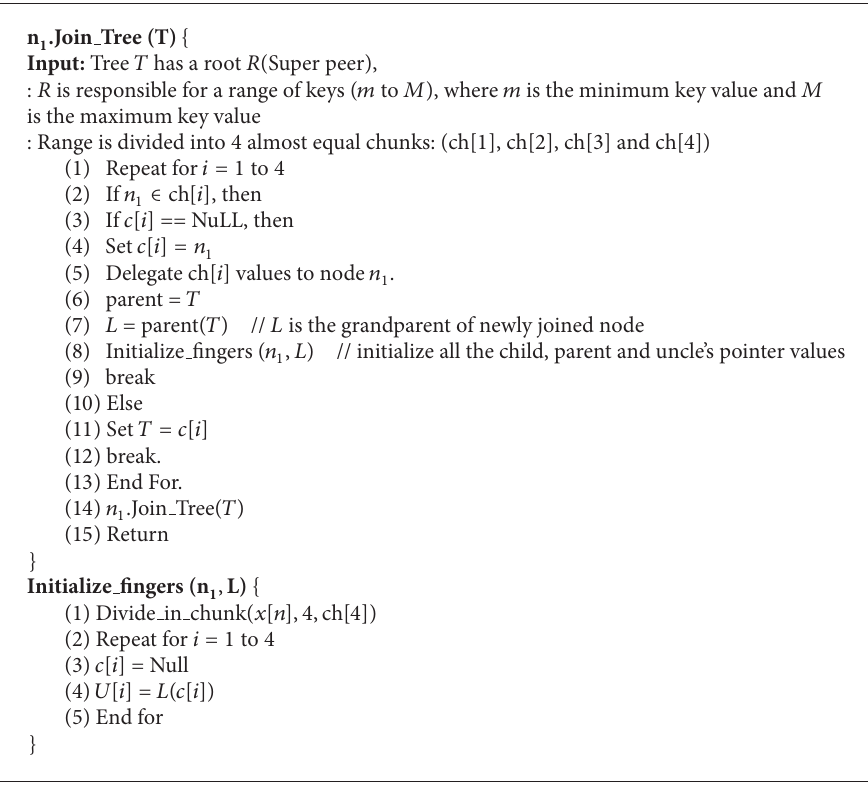
Algorithm 3: Peer join operation in the responsible tree of the proposed architecture.